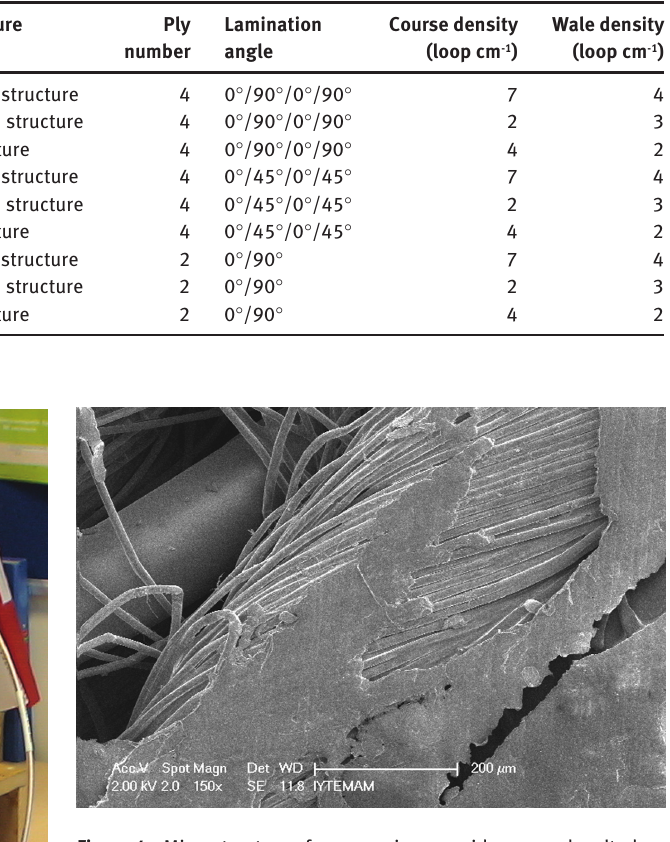
Figure 4 Microstructure of copper wire, aramid yarn, and melted polypropylene in knitted fabric